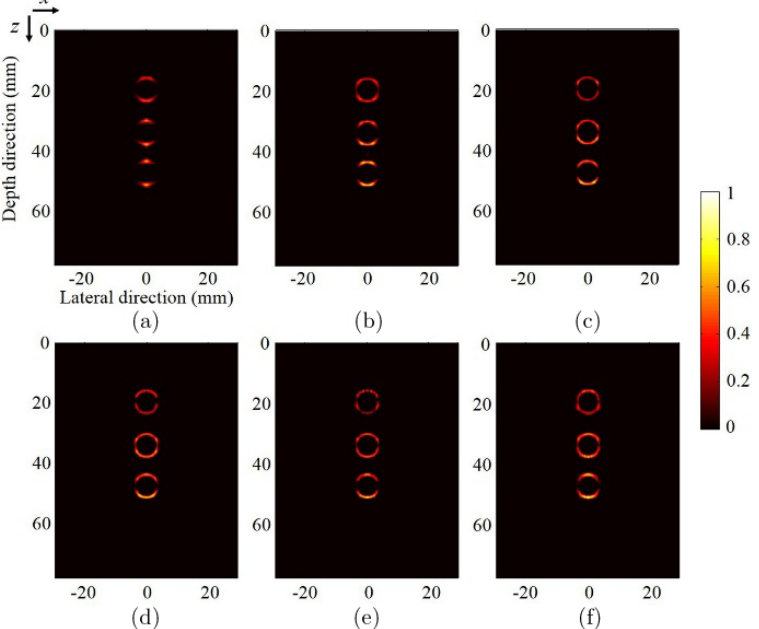
Fig. 4. Numerical simulation results of limited-view problem in synthetic aperture PAT. PA images recovered from single aperture with (a) 128 and (b) 128 (cid:3) 3 elements. (c) – (f) PA images recovered from aperture orientations of 45 (cid:1) , 60 (cid:1) , 75 (cid:1) , and 90 (cid:1) , respectively.